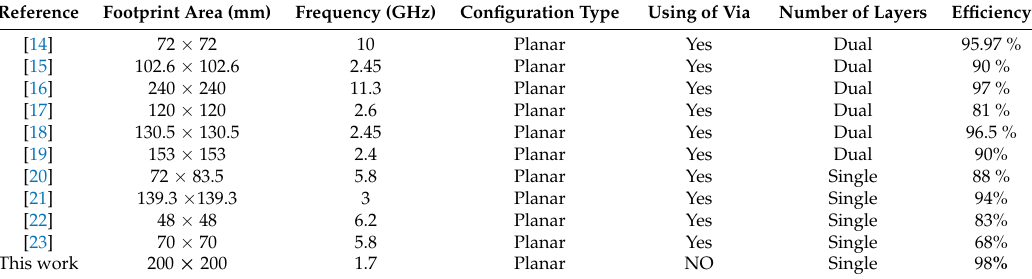
Figure 13. Numerical results showing the simulated radiation to dc efficiency. Table 1. A comparative study of the proposed dual polarized rectenna array with various state of the art published